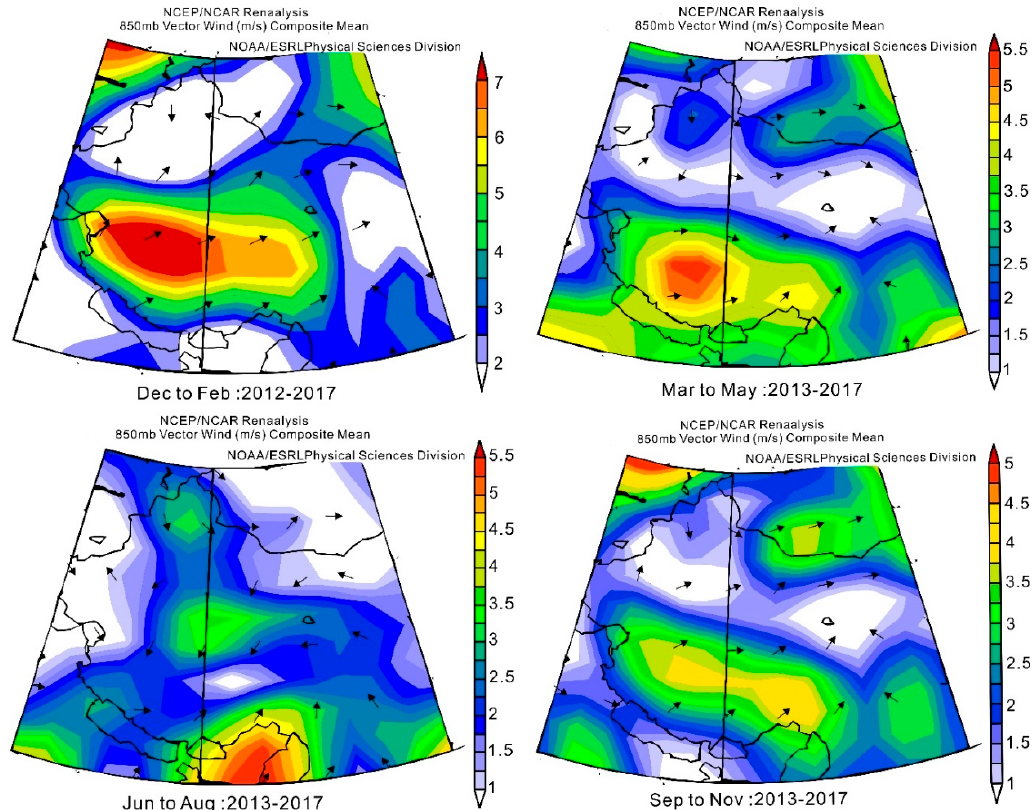
Figure 7. The mean wind vector data of 850mb wind in the study area during each season from 2012 to 2017, based on NCEP/NCAR (National Centers for Environmental Prediction/ National Center for Atmospheric Research) reanalysis data (https://www.esrl.noaa.gov/), reflecting the potential dust transport routes in northeast Tibetan Plateau and central Asia.